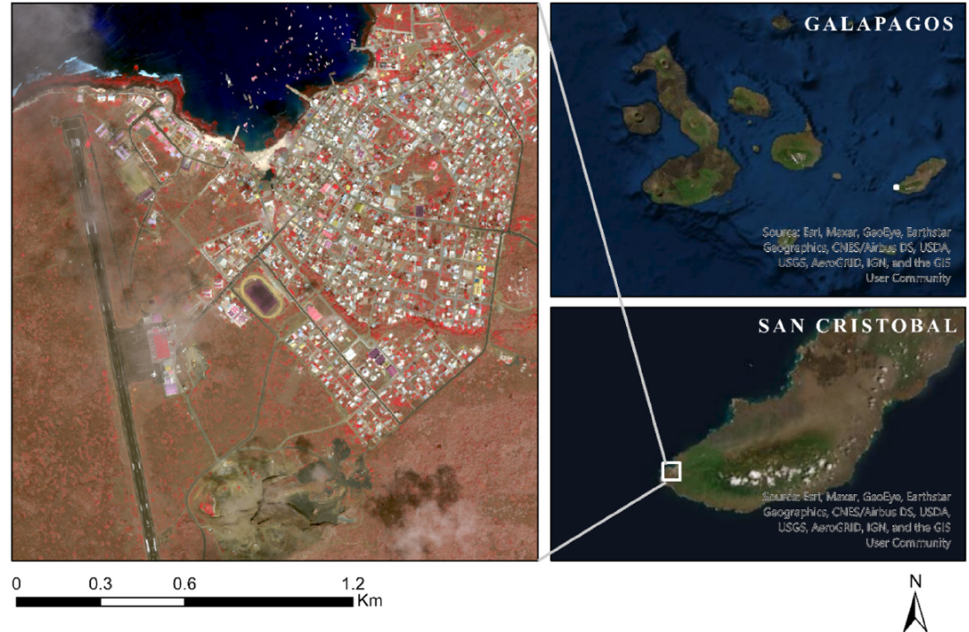
Figure 1. The port city of Puerto Baquerizo Moreno on San Cristobal Island of Galapagos. The VHR WorldView-2 imagery is presented in RGB false color combination.